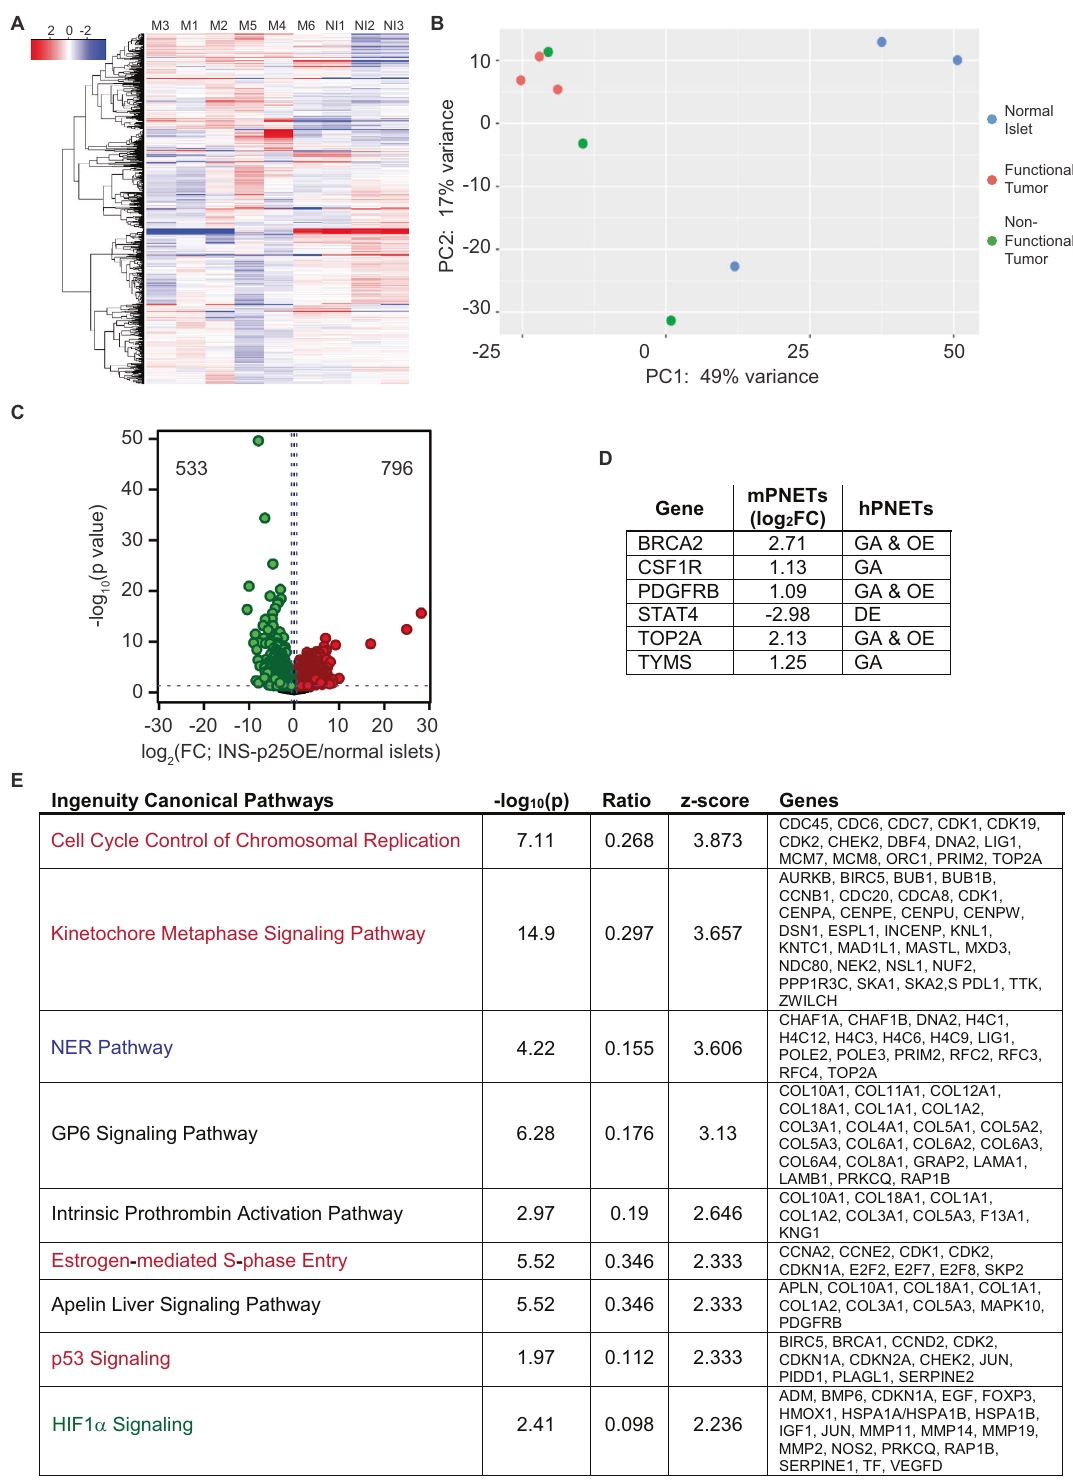
Fig. 5 Cdk5 upregulates cancer-related pathways. A Heatmap of differentially expressed genes in normal mouse islets (NI1 – 3), functional (M1 – 3) and non-functional (M4 – 6) INS-p25OE PanNETs. B Principal component analysis of expression data. C Volcano plot of annotated genes upregulated and downregulated in INS-p25OE tumors (all 6) compared to normal mouse islets; fold change (FC). D Table of differentially expressed genes that overlap with alterations in human PanNETs; gene ampli fi cation (GA), overexpression (OE), decreased expression (DE). E Ingenuity Pathway Analysis of genes differentially expressed between INS-p25OE tumors (all 6) and normal islets. Pathways are related to cell cycle (red), DNA repair (blue), vascularization (green), and extracellular matrix